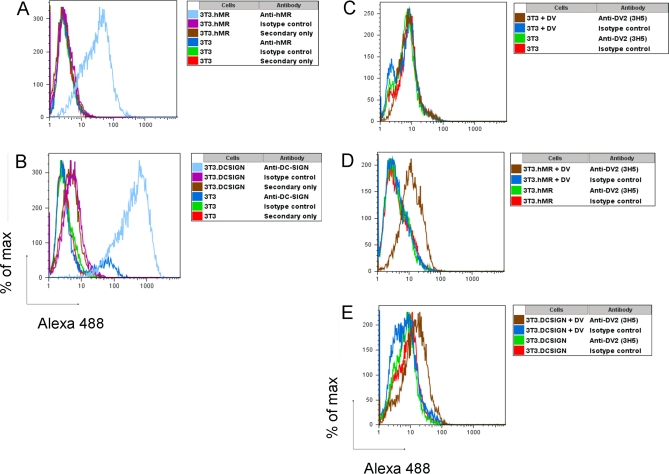
DV Binds to Cells Transfected with Human MR or DC-SIGNThe expression levels of (A) MR and (B) DC-SIGN on cells transfected with MR (3T3.hMR), DC-SIGN (3T3.DC-SIGN), or vector only (3T3) were assessed by flow cytometery. Receptor expression was detected with 15–2 (anti-hMR) or 120507 (anti-DC-SIGN) antibodies (pale and dark blue lines). Matched isotype control (purple and green lines) and secondary antibody only (brown and red lines) staining is included. Binding of NGC DV2 to cells transfected with (C) vector only (3T3), (D) MR (3T3.hMR), and (E) DC-SIGN (3T3.DC-SIGN) for 90 min on ice was detected by flow cytometry. The histograms show the binding of anti-DV2 antibody (3H5; brown and green lines) and isotype matched control antibody (blue and red lines). The relative fluorescence intensity was measured by FACSCalibur analysis and the data are normalised and presented as percent of maximum. Representative data from one of two independent experiments are shown.